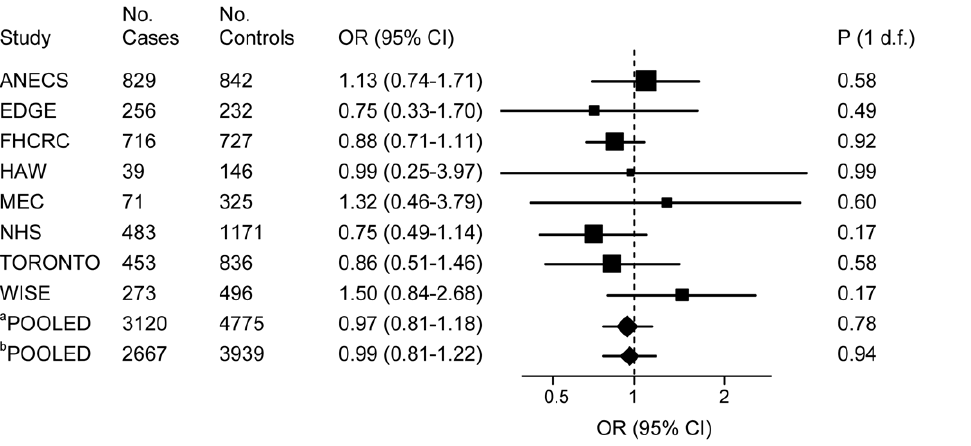
Figure 2. Association of the MC4R rs17782313 with endometrial carcinoma risk in non-Hispanic white women. Forest plot of the ORs and 95% CIs comparing endometrial carcinoma risk for the MC4R rs17782313 rare allele homozygotes (CC genotype) versus common allele homozygotes ( TT genotype) for eight studies included in the pooled analysis. The pooled a OR for all studies combined was 0.97 [95% CI: 0.81–1.18; p (1 d.f.) =0.78]. P for heterogeneity of effects by study=0.49. The pooled b OR for studies including incident cases only (excluding TORONTO study) was 0.99 [95% CI: 0.81–1.22; p (1 d.f.) =0.94]. P for heterogeneity of effects between studies with incident cases vs. prevalent cases (TORONTO) =0.68. Pooling was performed by combining all data using study as fixed and random effects (results were the same).